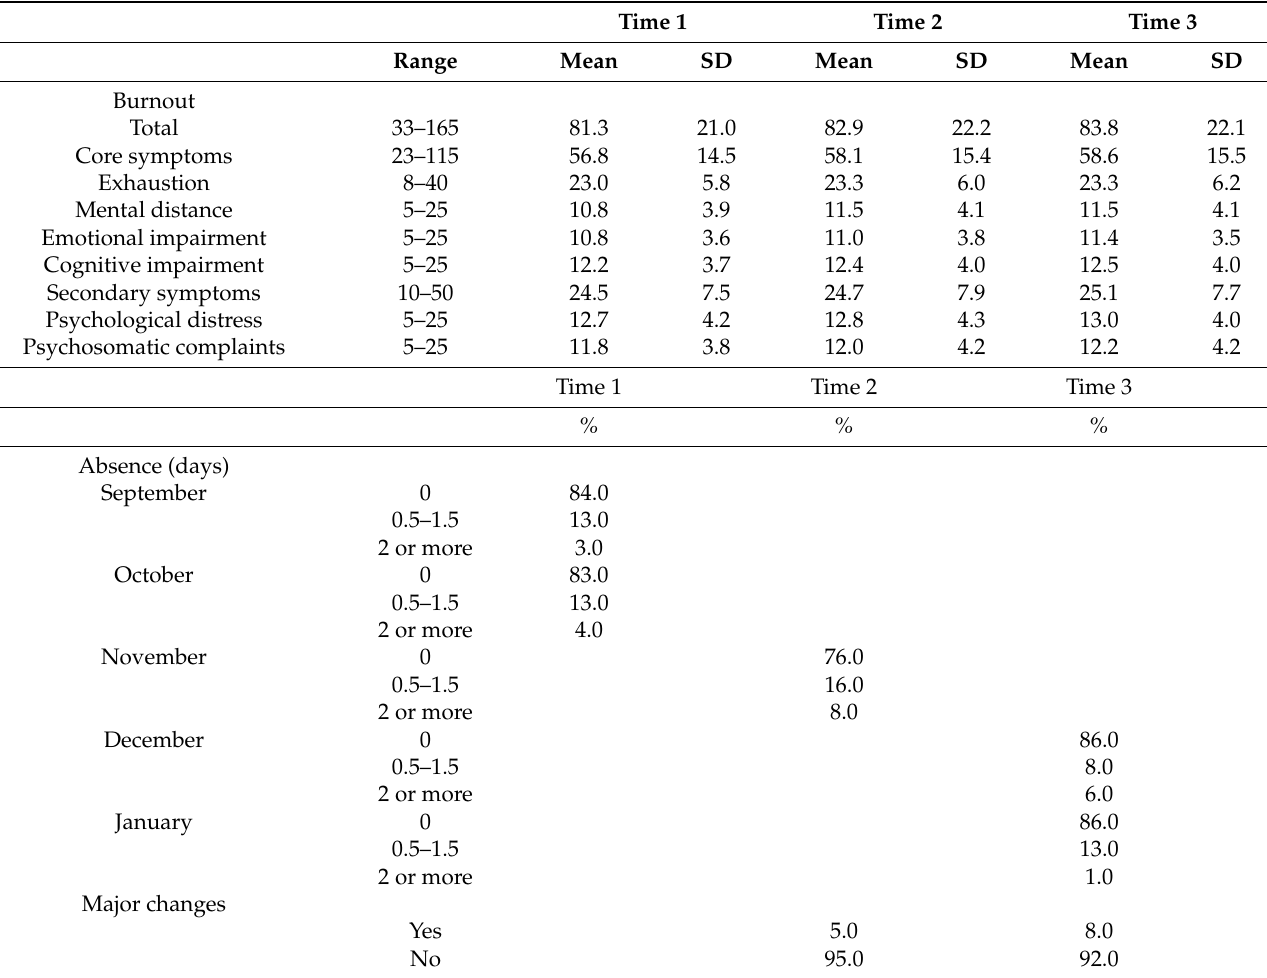
Table 2. Descriptive statistics of burnout, absence days, and major